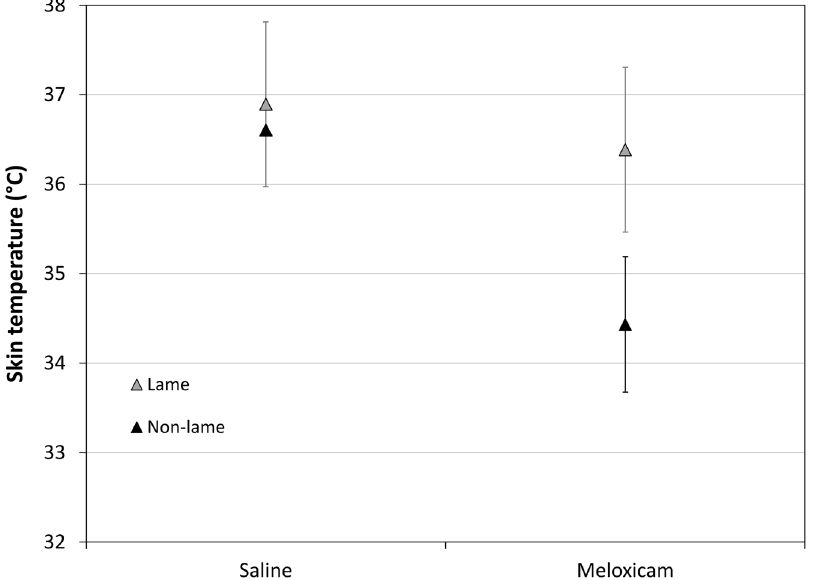
Figure 4. Effects of meloxicam on skin temperature. Modelled predictions (means 6 95% confidence intervals) of skin temperature for lame and non-lame birds administered saline or meloxicam (keeping all other variables in the model at reference values).